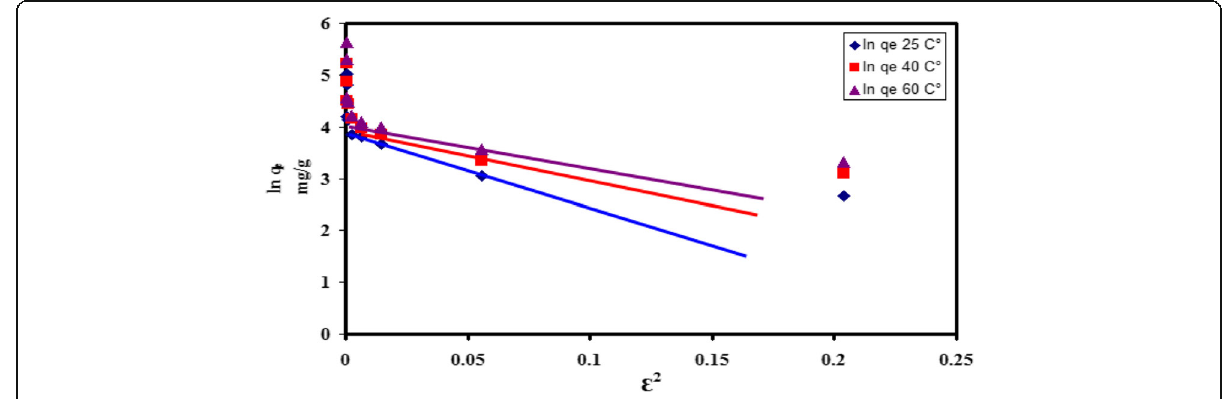
Fig. 18 Dubinin – Radushkevich isotherm model plot